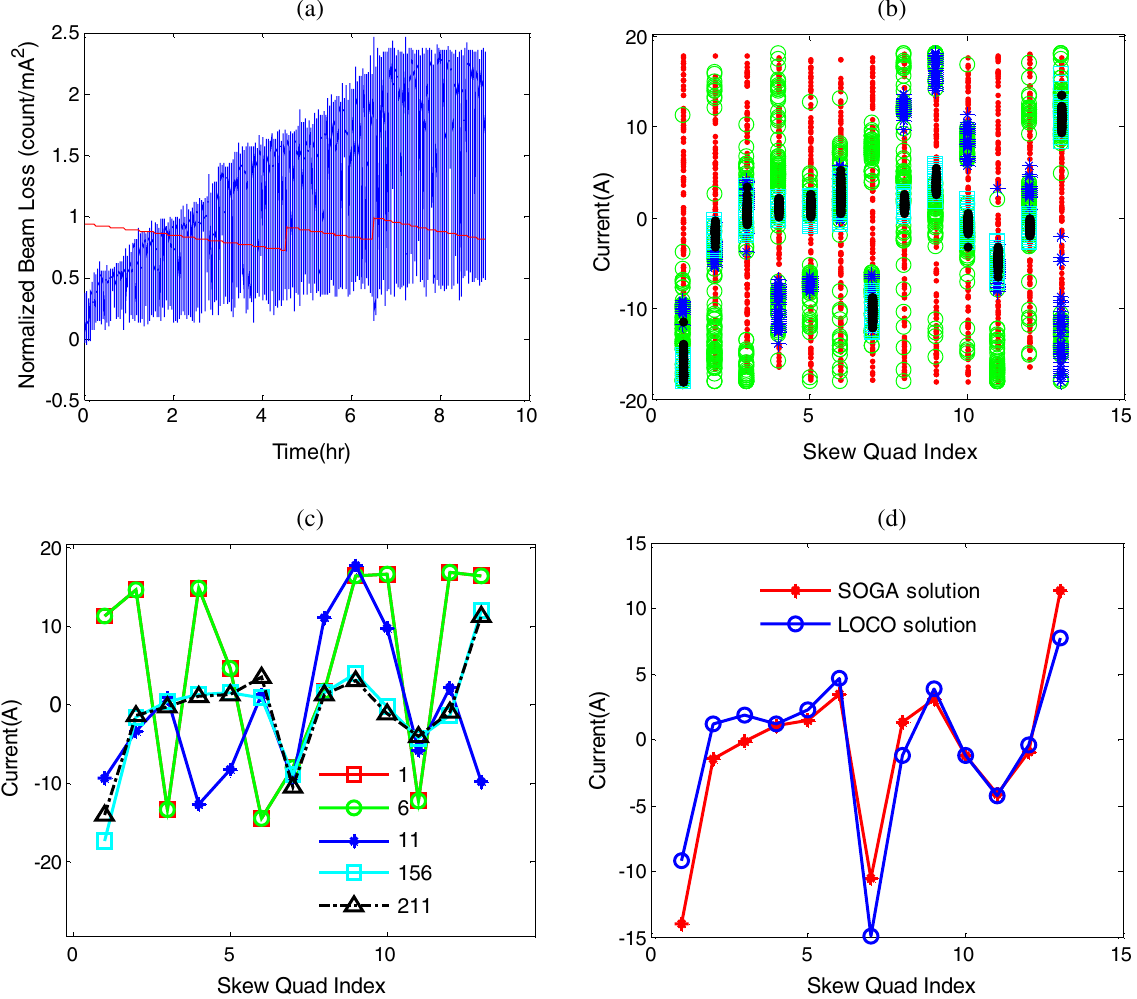
FIG. 3 (color online). (a) Normalized beam loss rates at the scraper during the experiment at 1 Hz update rate; (b) population for selected generations (red: 1st generation; green: 6th generation; blue: 11th generation; cyan: 156th generation; black: 211th generation); (c) the best solutions at selected generations; (d) comparison of the GA and LOCO